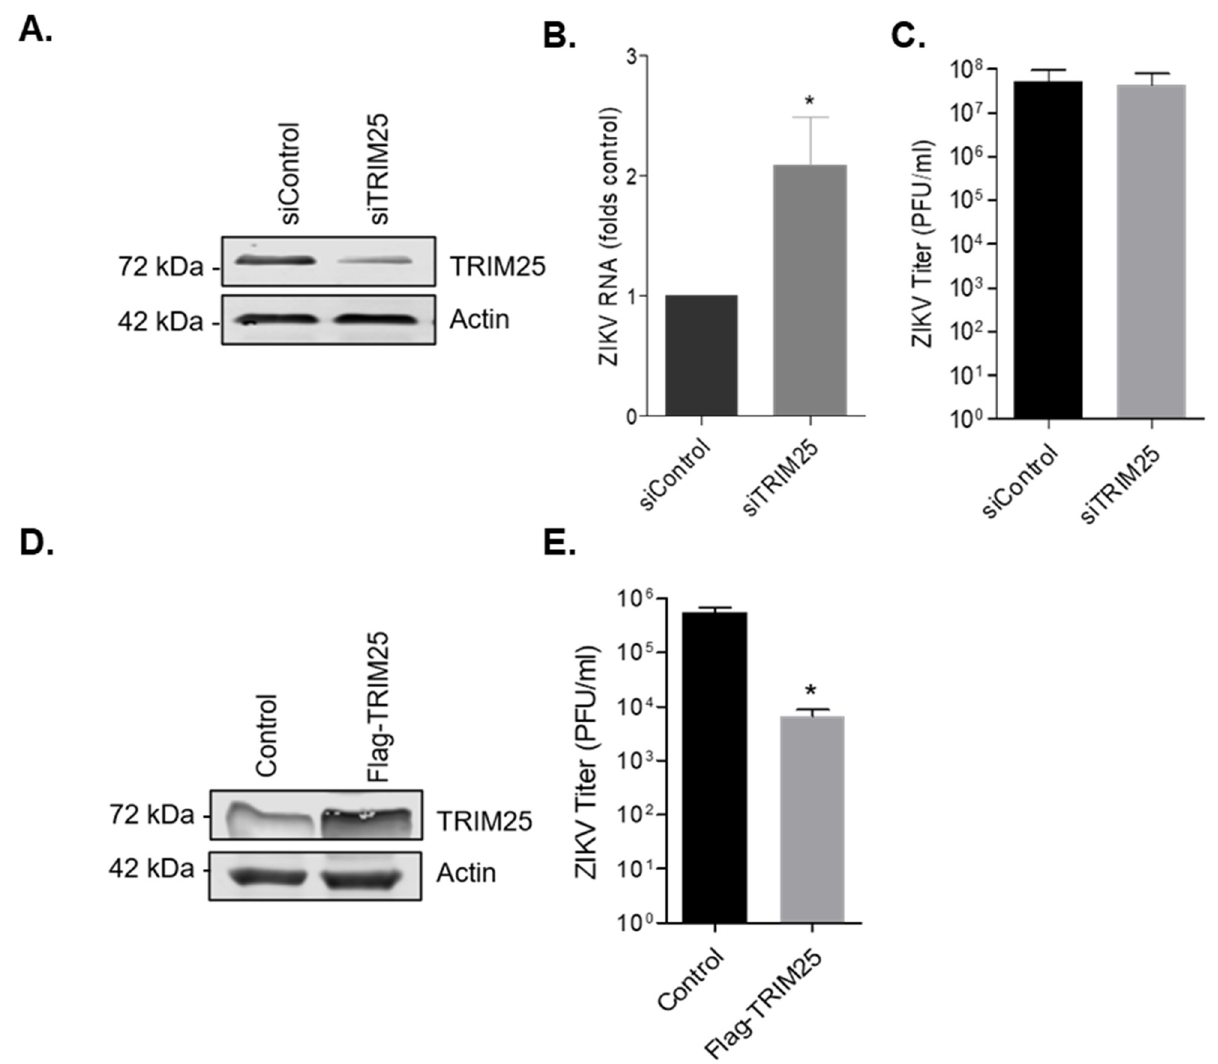
Figure 8. TRIM25 is a viral restriction factor. ( A ) A549 cells were transfected with siNon-targeting control (siControl) or siTRIM25 for 48 h, followed by infection with ZIKV (MOI of 3). Western blots of cell lysates 48 h post-transfection with desired siRNA and probed with antibodies for TRIM25 and actin. ( B ) Cellular RNA was extracted at 48 h post-infection, and qRT-PCR using ZIKV specific primers was performed. ( C ) Supernatant was collected for quantification by plaque assay. ( D ) A549 cells were transfected with pCDNA3.1 or pFlag-TRIM25 for 48 h, followed by infection with ZIKV (MOI of 3). Shown are the Western blots of cell lysates 24 h post-transfection and probed with antibodies for TRIM25 and actin. ( E ) Supernatant was collected for quantification by plaque assay. The average values from three independent experiments are shown. All data were subject to t-test analyses (* p ≤ 0.05).